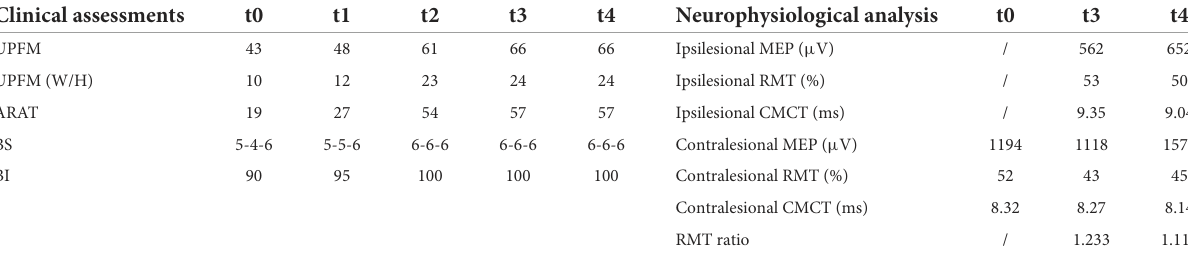
TABLE 1 Scores on clinical scales and neurophysiological evaluation